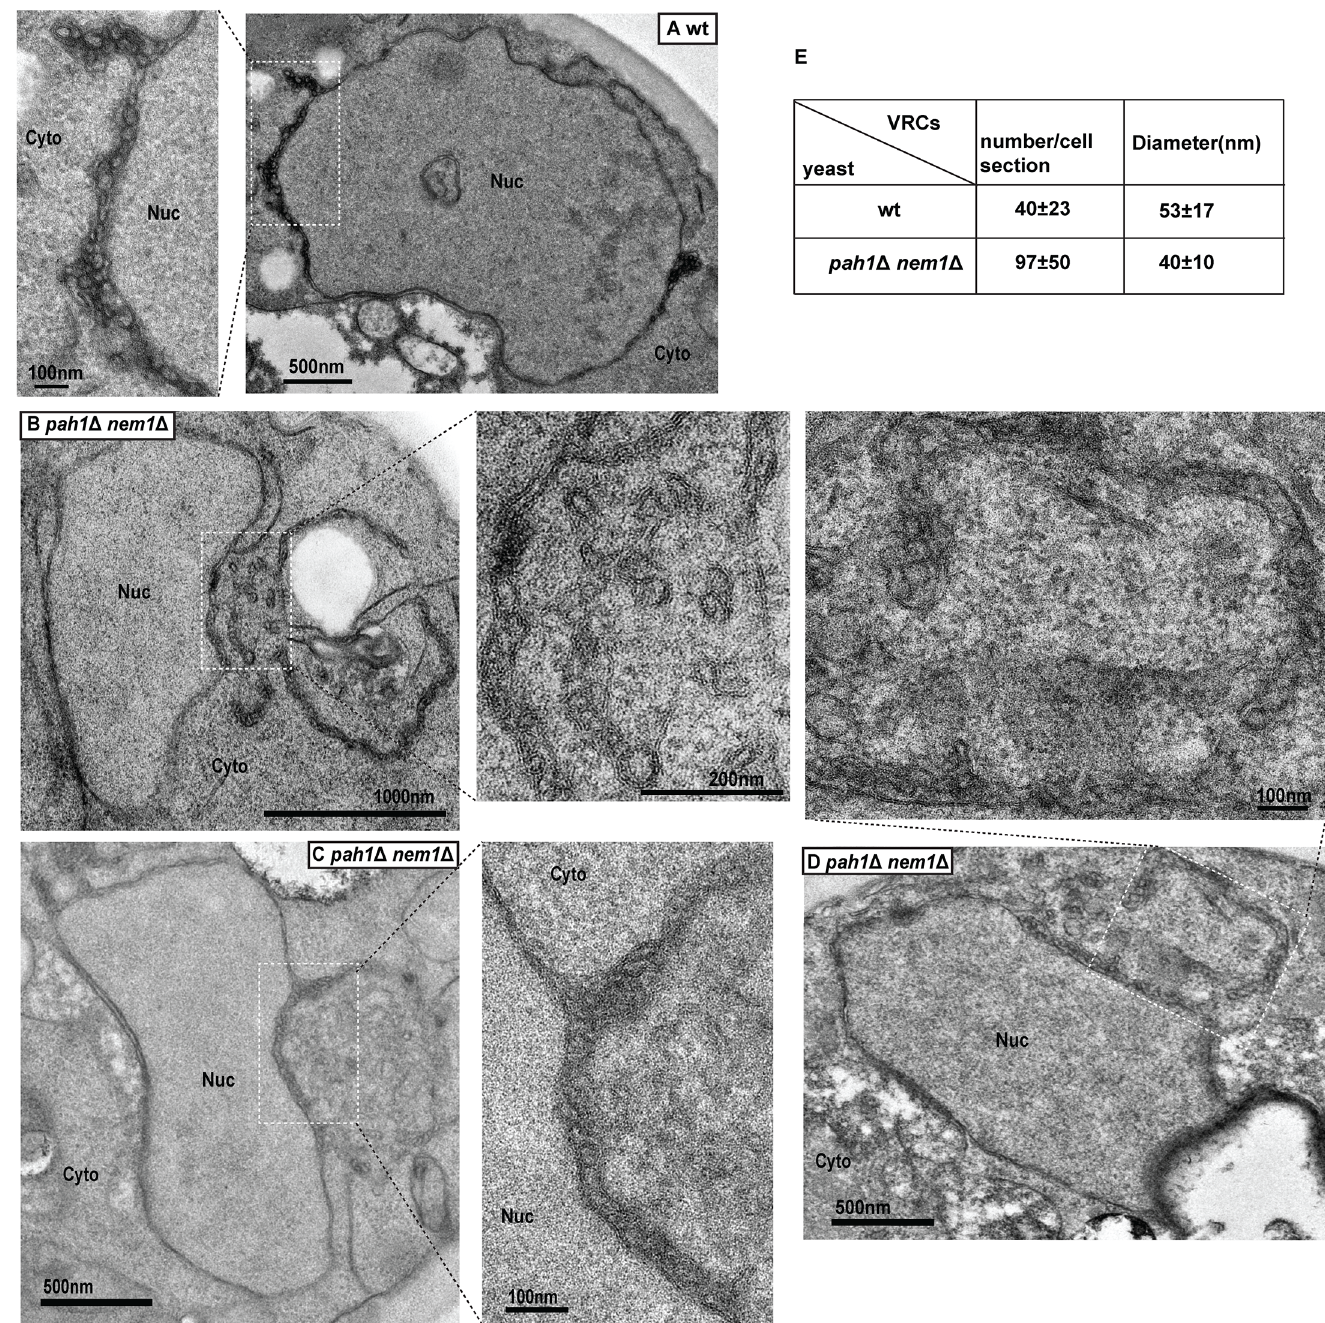
Fig 3. Number of spherular VRCs is substantially increased in pah1 Δ nem1 Δ cells. Electron micrographs of spherular VRCs formed in wt (A) and pah1 Δ nem1 Δ cells (B-D) are shown. Micrographs at a higher magnification of boxed areas are also shown. Note spherular VRCs are in membranes extended from the nER membrane. (E) Average number of VRCs per cell section and diameter of VRCs in wt and pah1 Δ nem1 Δ cells. Nuc, nucleus; Cyto, cytoplasm.